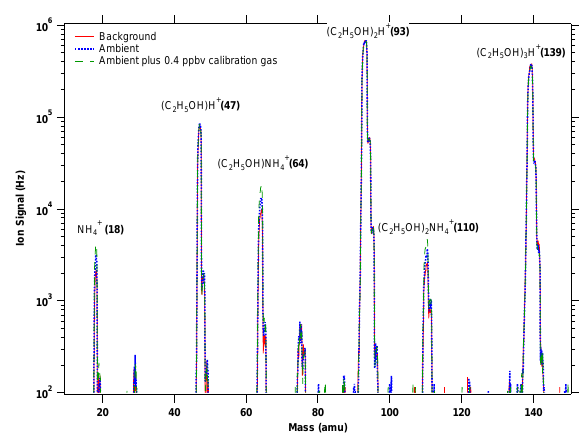
Fig. 2. Typical mass spectra taken for the background (red), ambi- ent (blue dotted), and ambient plus calibration mode (green dashed). The main reagent ion signals were (C 2 H 5 OH)H + (47amu), (C 2 H 5 OH) 2 H + (93amu), and (C 2 H 5 OH) 3 H + (139amu), and the main product ion signals were NH + (18amu), (C 2 H 5 OH)NH + 4